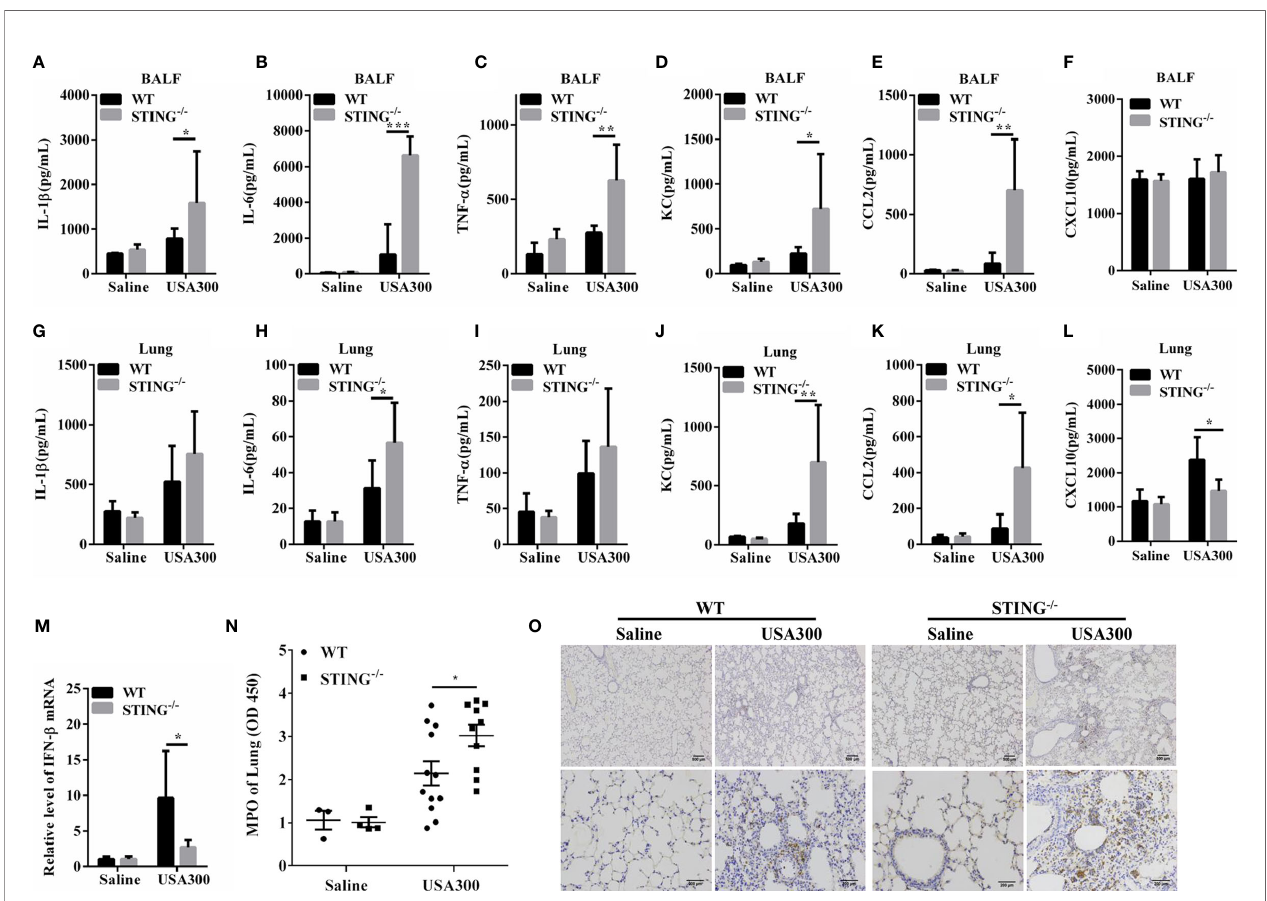
FIGURE 2 | STING de fi ciency leads to enhanced pro-in fl ammatory mediator production following S.aureus lung infection. WT and STING -/- mice (N = 7-8/group) were infected intranasally with S.aureus (1 × 10 8 CFU/mouse) for 24 h. The homogenate supernatants of lungs and BALF were detected for concentrations of indicated cytokines and chemokines by ELISA. (A, G) IL-1 b , (B, H) IL-6, (C, I) TNF- a , (D, J) KC, (E, K) CCL2, (F, L) CXCL10. (M) Lung tissue mRNA was examined for IFN- b by qRT-PCR. (N) The homogenate supernatants of lungs were also used to determine the activity of MPO (a neutrophil marker). (O) Representative immunohistochemical staining of Gr-1 (a neutrophil marker) was performed in the pulmonary sections. All data are shown as mean ± SEM. Student ’ s t-test was performed. Statistical signi fi cance is indicated by *p < 0.05, **p < 0.01, and ***p <